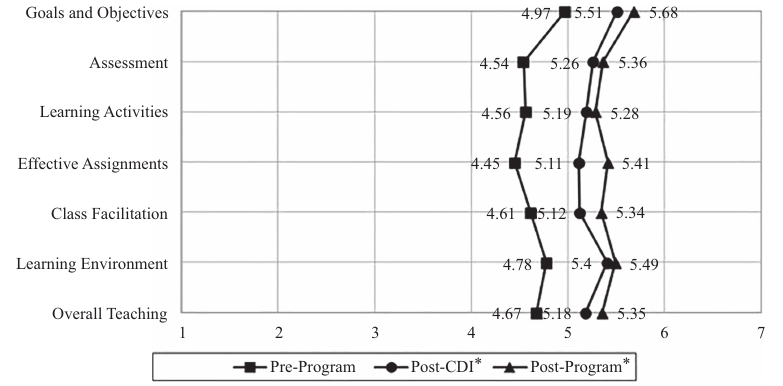
Figure 3. Participants ’ self- efficacy mean scores over time ( n 5